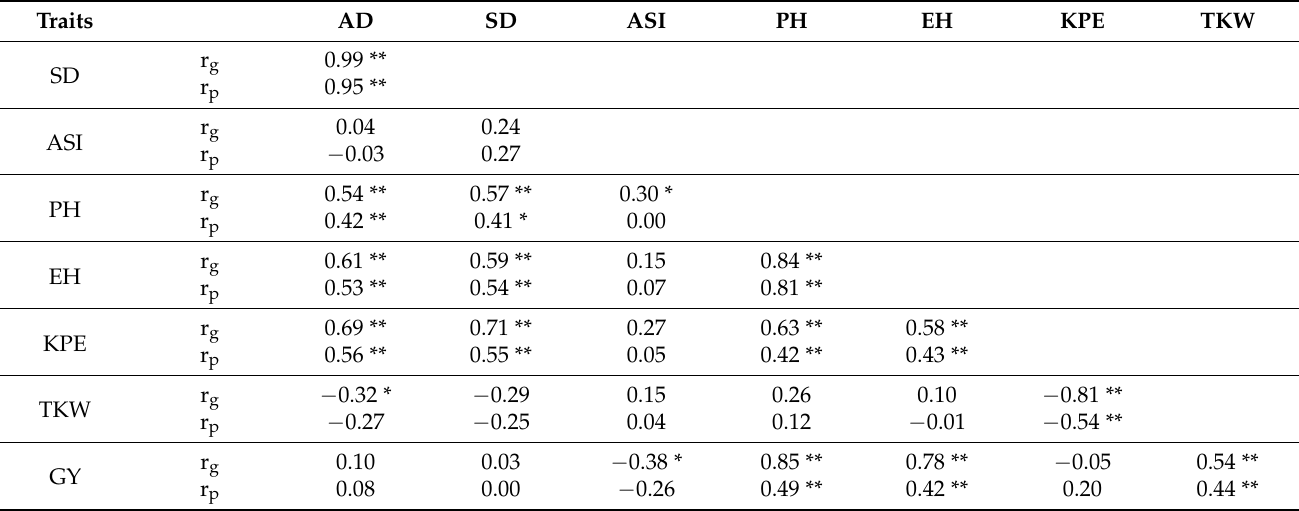
Table 4. Associations of different traits from the trial were evaluated at the Jashore